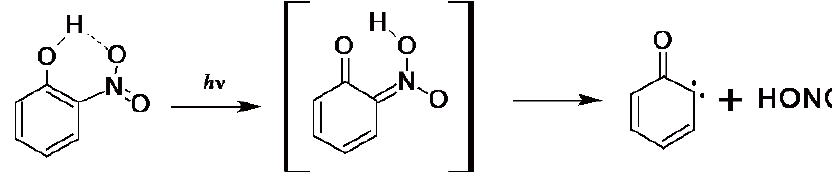
Fig. 1. Scheme of the HONO release from o -nitrophenol upon photoexcitation, adopted from Ref.